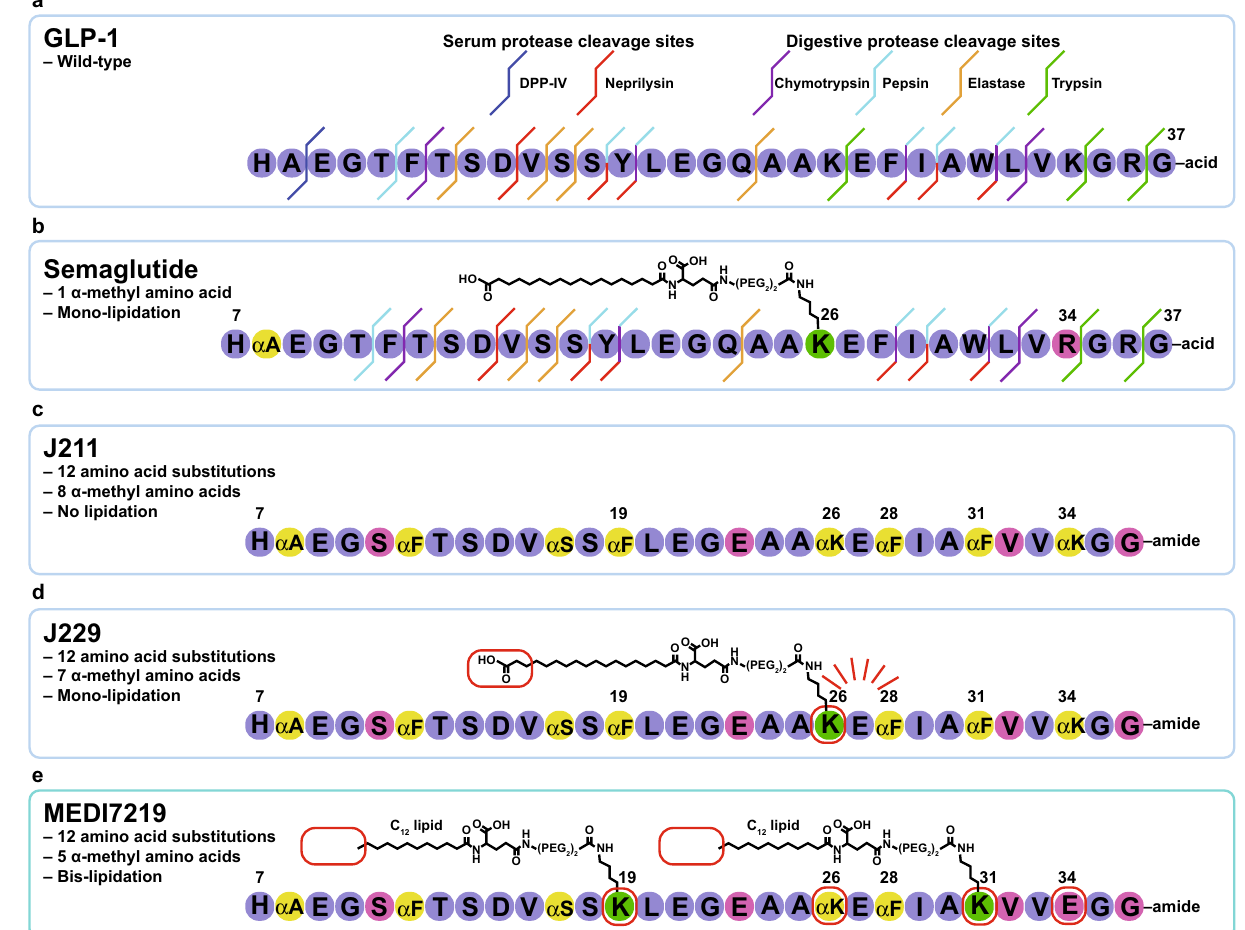
Figure 1. GLP-1RA design. ( a ) Amino acid schematic of wild-type GLP-1-(7–37) peptide showing protease cleavage sites. ( b ) Amino acid schematic of semaglutide showing amino acid substitution, site of lipidation and remaining protease cleavage sites. ( c ) Amino acid schematic of J211 showing amino acid substitutions. ( d ) Amino acid schematic of mono-lipidated J229. Red lines around positions 26–28 represent protection from trypsin provided by lipidation of Lys 26 . ( e ) Amino acid schematic of MEDI7219 peptide bis-lipidated with dodecanoic acid. Red boxes highlight differences compared with previous analogue for c–e . *Amino acid numbering starts at 7 because active form of GLP-1 is cleaved from proglucagon to form GLP-1-(7